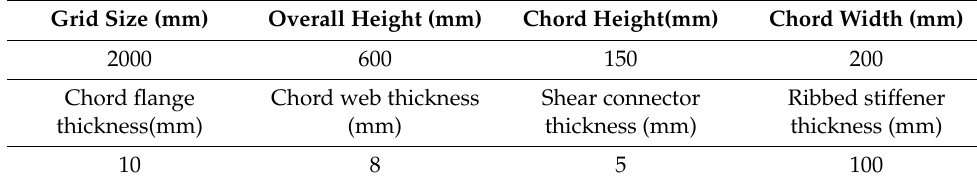
Table 7. Model common